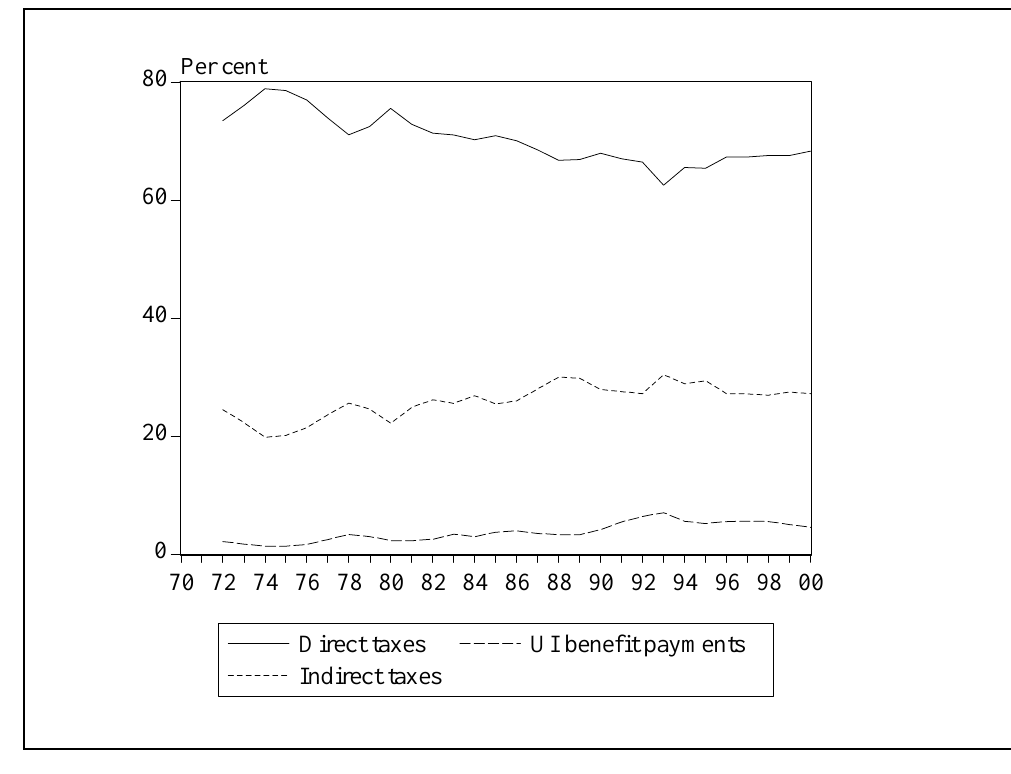
Contributions to the total cyclical component of the budget balance